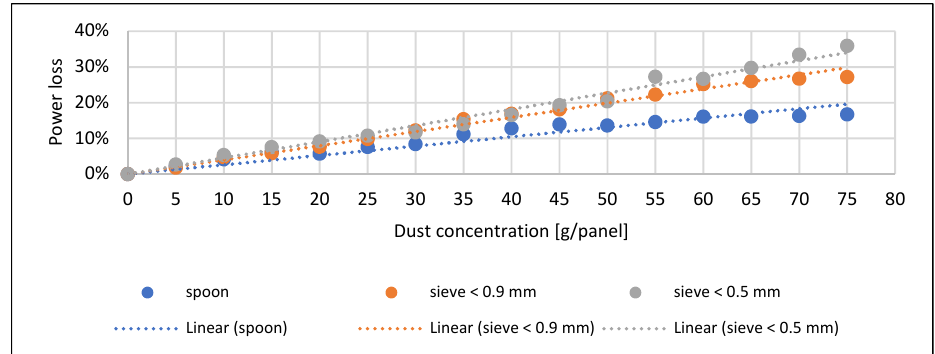
Figure 9. Power loss values as a function of the sand concentration. Only at higher concentrations could significant differences be observed, which were already due to the degree of spreading on the surface. In the case of the sand, the finest particle size caused the maximum current reduction. In the case of the soil, the order and pattern of the trend lines correspond to the pre ‐ expected picture. The voltage drop meas ‐ ured when the fly ash spread with a spoon is significantly lower than the results obtained with sieving. This drop can be explained by the fly ash forming a thick thermal insulating layer over the entire surface of the solar cell during sieving (Figure 10). The current de ‐ crease and power loss are smaller at higher concentrations due to the early and significant spreading material on the surface due to the density of the material (Figure 11 and Figure 12). Similar trends can be observed in the study of Abderrezek et al. [5], Bhattacharya et al. [18], and Oh et al. [26].